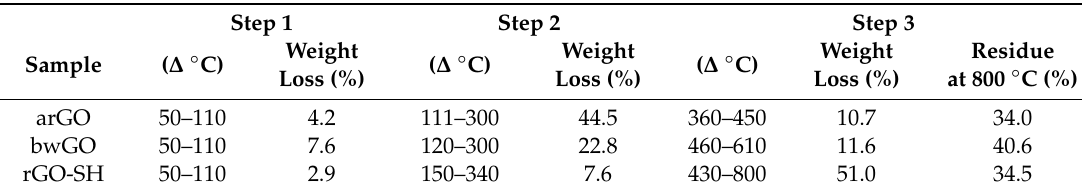
Figure 2. TGA curves recorded under nitrogen flow for the lyophilized powers of as-received GO (solid line), base-washed GO (dashed line), and thiolated reduced GO (dotted line). Table 2. Characteristic weight loss (%) as function of temperature steps calculated from TGA analyses for as-received GO, base-washed GO, and thiolated reduced